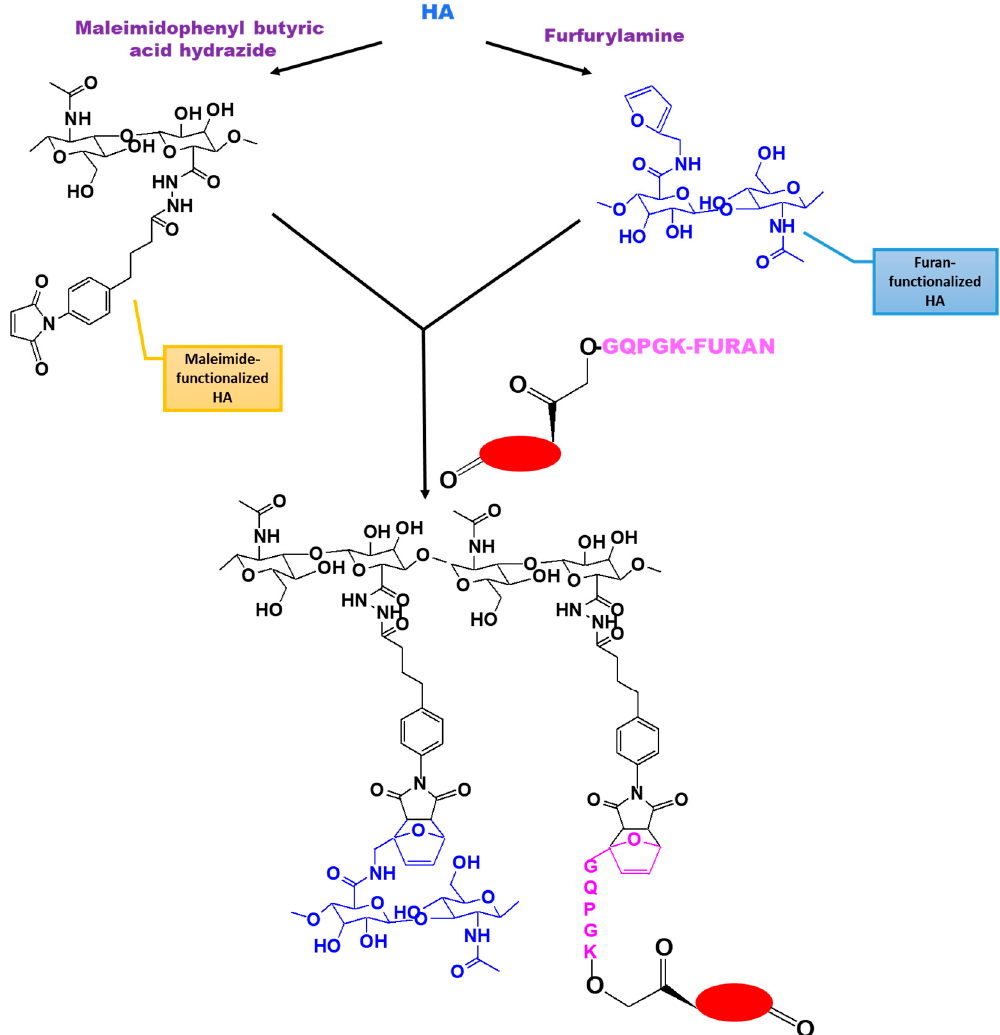
Figure 9. Scheme for the synthesis of a dexamethasone conjugate with hyaluronic acid maleimide by Diels–Alder cycloaddition [91].